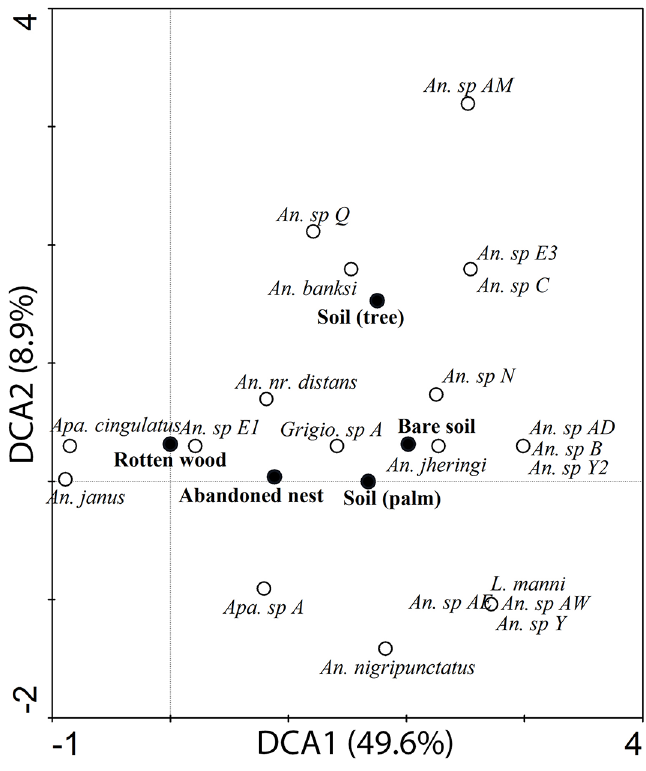
Fig 1. DCA bi-plot of termite species and substrate types. Solid symbols: substrate; open symbols: termite species.